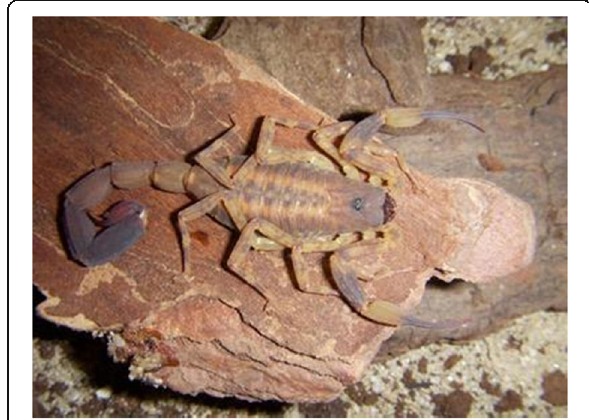
Fig. 7 Tityus costatus. This species is yellowish brown with spots on the legs and palps. It can measure from 5 to 7 cm in length. Source: Brazilian Ministry of Health [6]. Image copyright by Denise Cândido, reproduced with permission